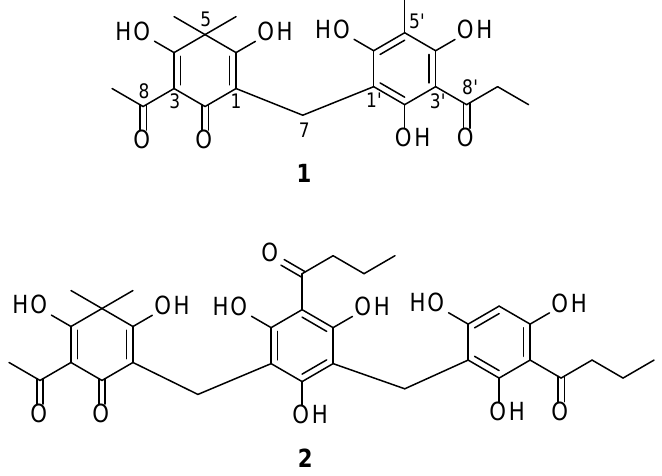
Figure 1. Chemical structure of flavaspidic acid AP ( 1 ) and nortrisflavaspidic acid ABB ( 2 ). Physical and spectroscopic data of isolated compounds: Flavaspidic acid AP ( 1 ): Yellow needles; 1 H-NMR (CD 3 OD, 500 MHz): 3.46 (2H, s, H-7), 2.43 (3H, s, H-9), 1.28 (each 3H, s, H-11, H-12), 3.15 (2H, q, J = 7.3 Hz, H-9 (cid:48) ), 1.15 (3H, t, J = 7.3 Hz, H-10 (cid:48) ), 1.96 (3H, s, H-11 (cid:48) ); 13 C-NMR (CD 3 OD, 500 MHz): 108.7 (C-1),